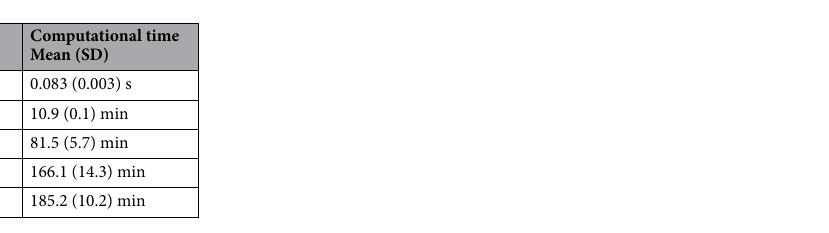
Table 1. Mean computational time required by the different registration